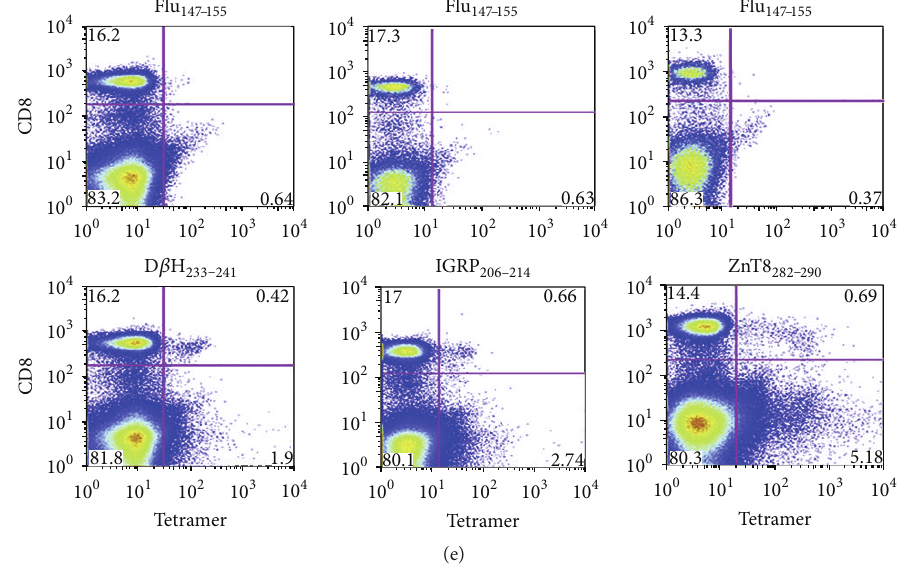
Figure 1: (a) Proliferation assay of PLN cells. 2 × 10 5 LN cells were mixed with 5 × 10 5 mitomycin C-treated spleen cells plus peptide for 48 h before pulsing with [ 3 H]-thymidine and scintillation counting. Shown is data from 1 of 5 assays. “Fold stimulation” ( 𝑦 -axis) is the average thymidine incorporation at a given peptide concentration divided by average incorporation into wells pulsed with Flu NP 147 expression of LN cells. Expression of IFN- 𝛾 was assayed as described in “Section 2”. In brief, PLN were isolated from NOD mice (3 weeks, striped bars; 13 weeks, white bars; and diabetic mice, black bars), pulsed with peptides for 48 h, and supernatants were analyzed by ELISA for IFN 𝛾 production. Shown is data from 1 of 2 assays. (c) RMA-S stabilization assay. Plotted are the ratios of MFI values of peptide-pulsed RMA-S cells to nonpulsed cells stained with either anti-K d or D b . For each peptide as indicated the stabilization assay was performed > 3 times. (d) Tetramer analysis of NOD spleen cells. Tetramers were used together with anti-CD8 to stain spleen cells of different aged NOD mice (as indicated) as described in “Section 2.” Plotted are tetramer positive cells as a percentage of CD8 cells. (e) Example of tetramer analysis of NOD spleen cells. As example of the data used to generate (d), Anti-Flu NP 147 (bottom panels) tetramers were used together with anti-CD8 to stain spleen cells of 13-week-old NOD mice as described in “Section 2.” D 𝛽 H tetramer positive cells were 0.42% of CD8 + cells, IGRP tetramer positive cells were 0.66% of CD8 + cells, and ZnT8 positive cells were 0.69% of CD8 +